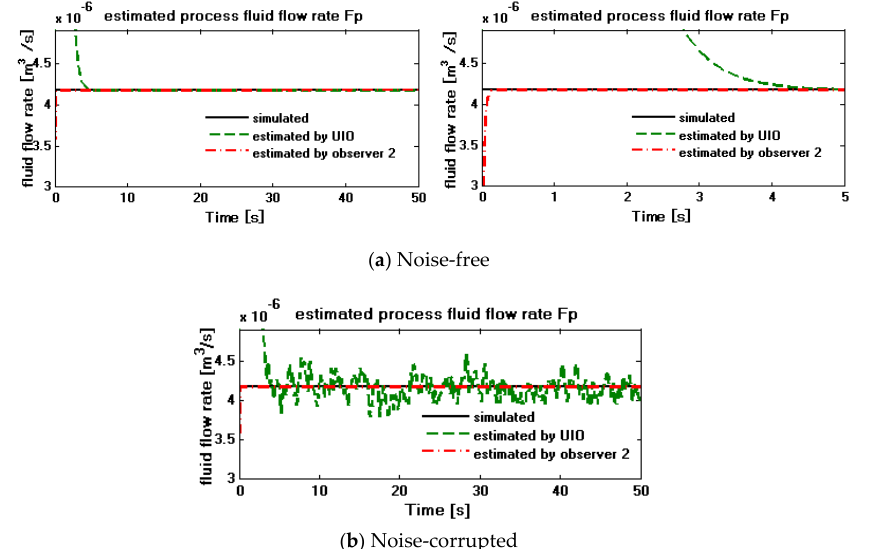
Figure 5. The computation and estimation of the process fluid flow rate F p . The solid line is the computed value; the dashed line is estimated by the unknown input observer (UIO); and the dashed, dotted line is estimated by Observer 2. ( a ) represents Noise-free case while ( b ) represents Noise-corrupted